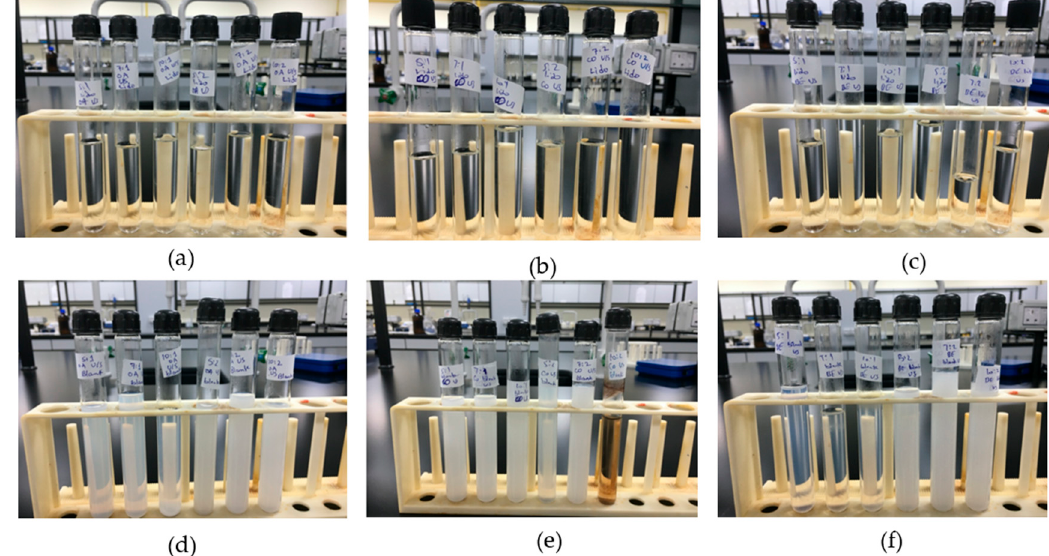
Figure 2. Lidocaine-loaded nanoemulsions with ( a ) oleic acid; ( b ) coconut oil; and ( c ) beeswax. Blank nanoemulsions with ( d ) oleic acid; ( e ) coconut oil; and ( f ) beeswax.